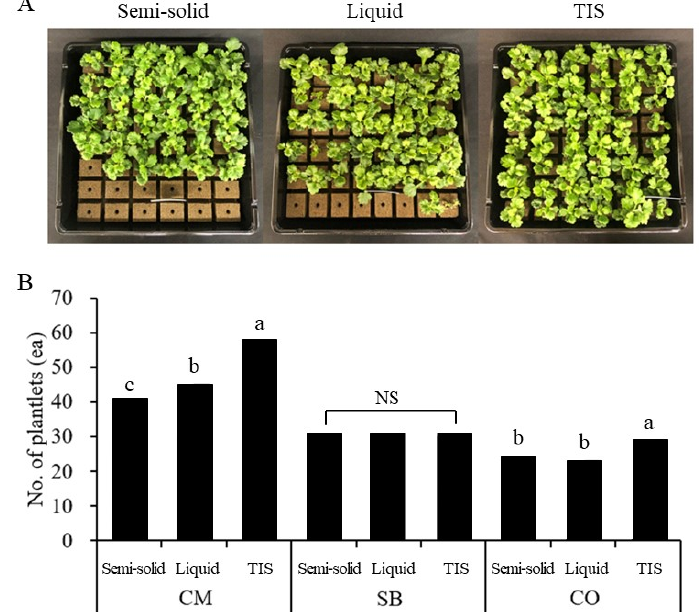
Figure 7. Acclimatization of in vitro grown chrysanthemum (CM), strawberry (SB), and Cnidium officinale (CO) plants in TIS and semi-solid and liquid cultures. ( A ) Acclimatized chrysanthemum plants after 4 weeks harvested from semi-solid, liquid, and TIS cultures. ( B ) Number of acclimatized plants after acclimatization of semi-solid, liquid, and TIS cultures. NS: no significance. Different letters differ significantly from each other by Duncan’s multiple-range test (DMRT; p ≤ 0.05).